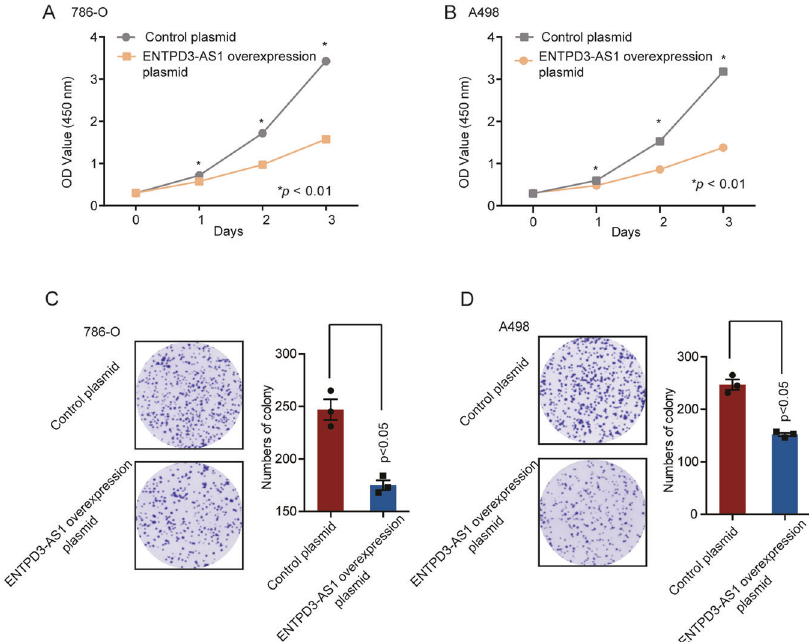
Fig. 4 The in vitro functional assays of ENTPD3-AS1. A , B Cell proliferation was measured in 786-O and A498 cells after being transfected with ENTPD3-AS1 overexpression plasmid. C , D Colony formation was measured in 786-O and A498 cells after being transfected with ENTPD3- AS1 overexpression